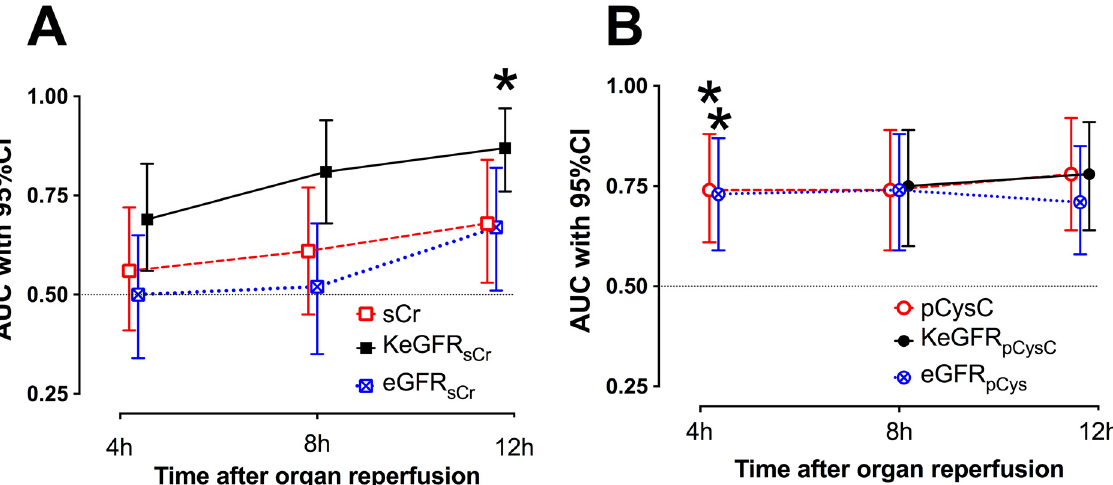
Fig 2. KeGFR versus eGFR, and KeGFR sCr vs. KeGFR pCysC . A — C: Unadjusted eGFR sCr and KeGFR sCr values stratified for DGF (red) or Non-DGF (black) at 4h (A), 8h (B), and 12h (C). D: Bland-Altman Plot comparing eGFR and KeGFR at 4h (blue triangles), 8h (open squares), and 12h (red circles) after kidney transplantation. Dotted line represents bias (mean difference between parameters); dashed lines represent 95% limits of agreement. E and F: Values for each patient of eGFR pCysC and KeGFR pCysC stratified for DGF or Non-DGF at 8h (E) and 12h (F) G: Bland-Altman Plot comparing eGFR and KeGFR at 8h and 12h after kidney transplantation. H: Bland-Altman Plot comparing KeGFR sCr and KeGFR pCysC at 8h and 12h after kidney transplantation. There was no